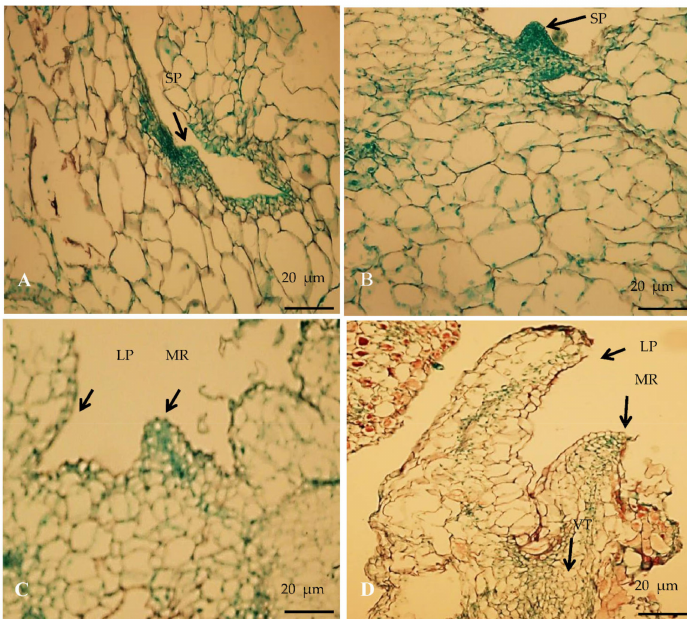
Figure 2. Histological analysis of the sequence of development of regenerated shoots from leaf explants of L. chinense cultured on MS supplemented with 0.5 mg/L TDZ. ( A ) Arrow head in- dicates the development of bud primordia from a meristematic dome after one week of culture (bar = 20 µ m). ( B ) Development of shoot primordia (SP) from a leaf explant after two weeks of cul- ture (bar = 20 µ m). ( C ) Multiple regenerated shoots on the surface of a leaf explant after four weeks of culture (bar = 20 µ m). ( D ) Longitudinal section of a bud connected to a leaf explant, showing the leaf primordia (LP), shoot apical meristem (MR), and vascular tissue (VT) after 24 days of culture (bar = 20 µ m).